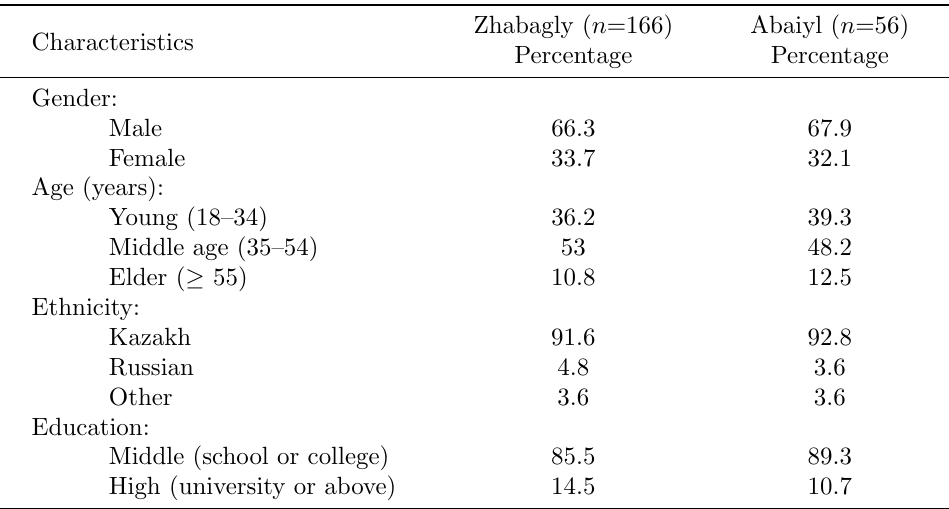
Table 1: Details of resident sample responses (n =